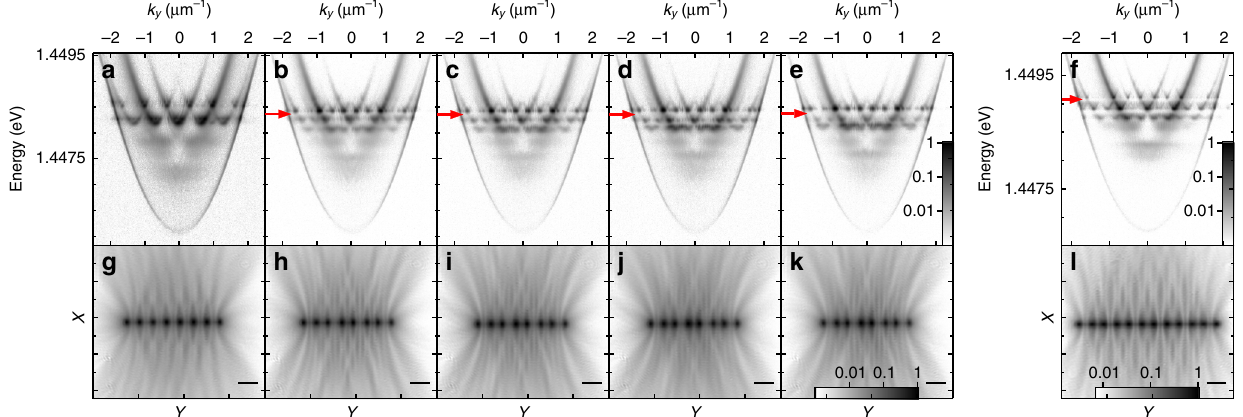
Fig. 2 Experimental demonstration of a band gap opening as the difference between the long ( a l ) and short ( a s ) separation is increased. Experimental dispersion ( a – f ) and corresponding real-space intensity distribution ( g – l ) of the PL from chains of eight polariton condensates with alternating separation distances where a l ≈ 10.4 μ m and a , g a s ≈ 10.4 μ m, b , h a s ≈ 9.0 μ m, c , i a s ≈ 8.9 μ m, d , j a s ≈ 8.7 μ m, and e , k a s ≈ 8.5 μ m. f , l shows the PL dispersion and real-space intensity distribution, respectively, for a chain of 12 condensates with a l ≈ 10.2 μ m and a s ≈ 9.2 μ m. The horizontal bars in the bottom right corner of each real-space distribution correspond to 15 μ m and the red arrows indicate the gap opening in the dominantly occupied band. a – e are plotted using the logarithmic colour scales shown in e and g – k are plotted using the logarithmic colour scale shown in k